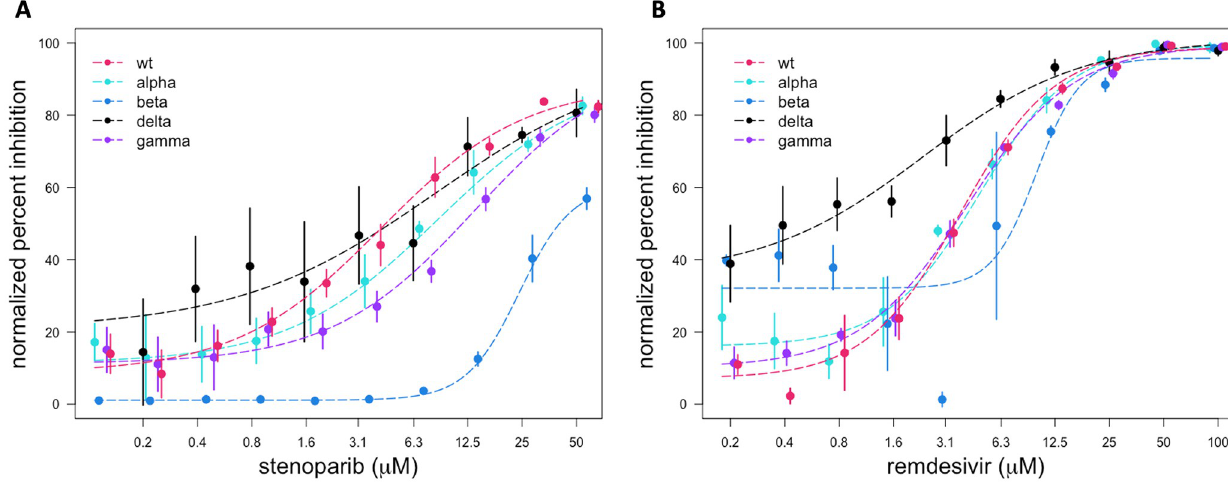
Fig 1. Dose-response curves for stenoparib and remdesivir on wild type SARS-CoV-2 and four variant SARS-CoV-2 strains. Normalized percent inhibition (Y-axis) of wt SARS-CoV-2 and variant strains alpha , beta , delta , and gamma in Vero E6 cells treated with (A) stenoparib or (B) remdesivir at the indicated concentrations (X-axis). Error bars are the standard